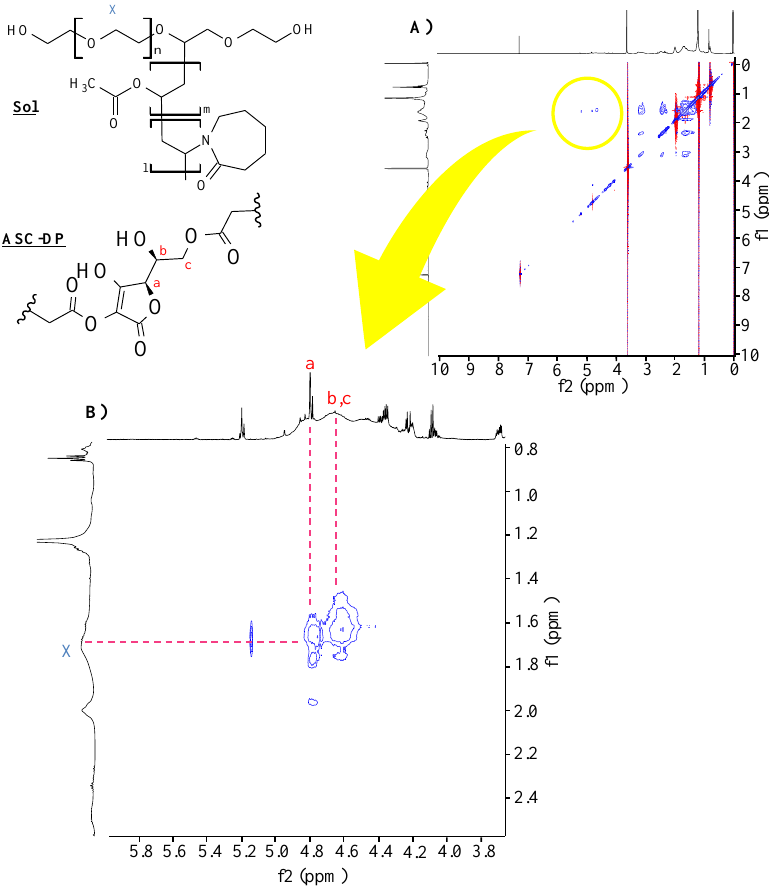
Figure 11. 1H-1H NOESY NMR spectra EVP (Sol/ASC-DP = 8/2) in CDCl3. ( A ) f1 is 0–10 ppm; f2 is 0–10 ppm. ( B ) f1 is 1.4–1.8 ppm; f2 is 4.5–4.8 ppm.